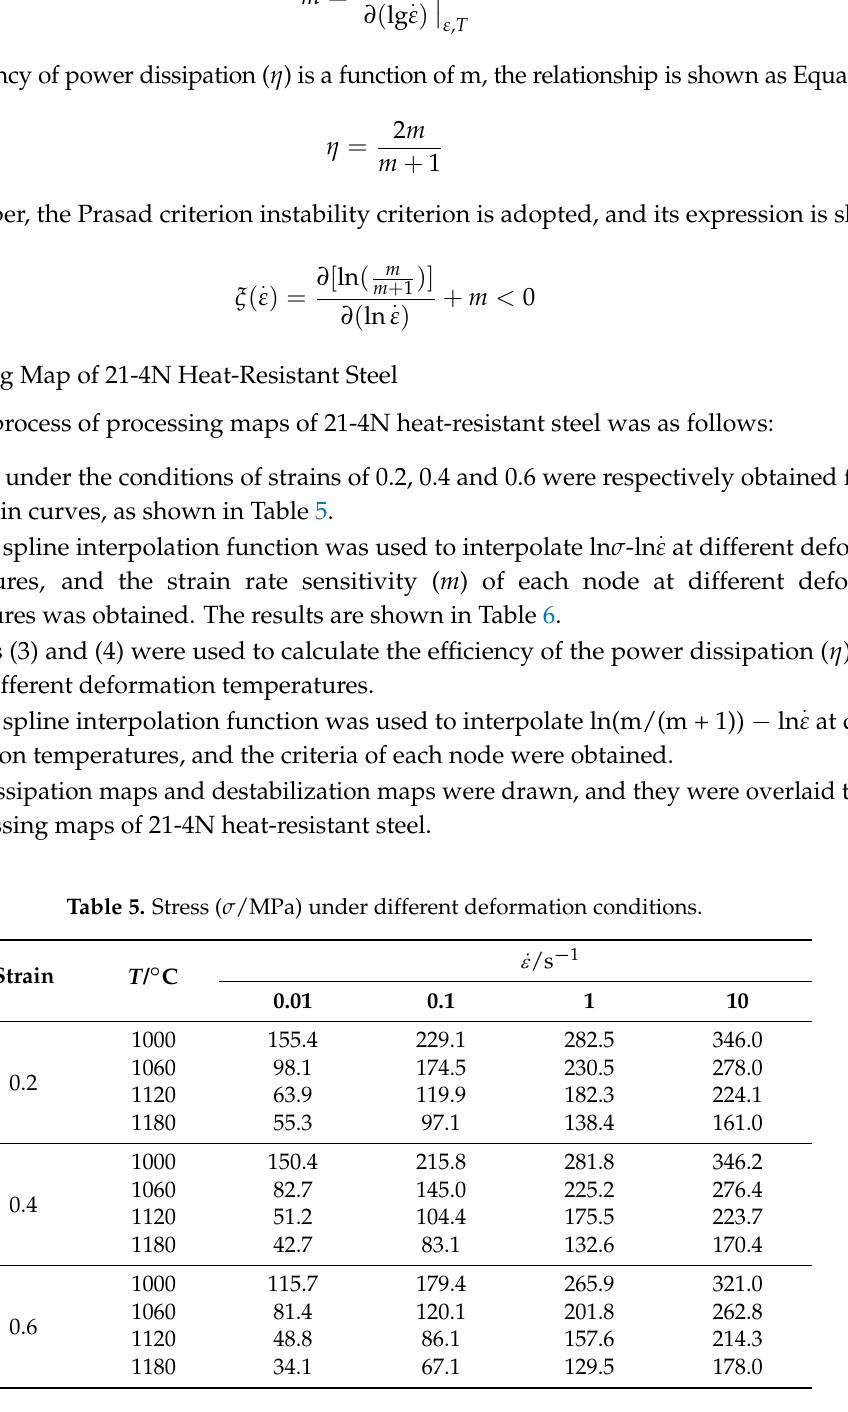
Figure 7. The correlation between experimental stress and predicted stress of the peak stress of 21-4N heat-resistant